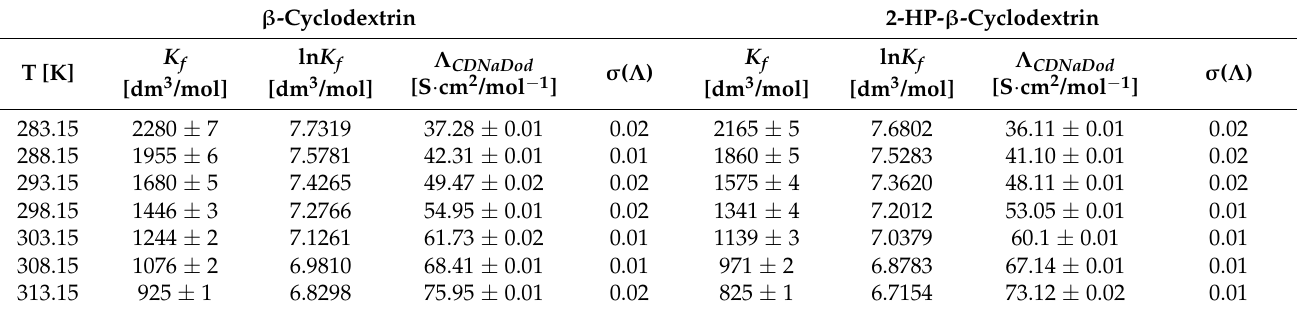
Table 4. The value of constant formation K f [dm 3 /mol], theoretical conductivity Λ